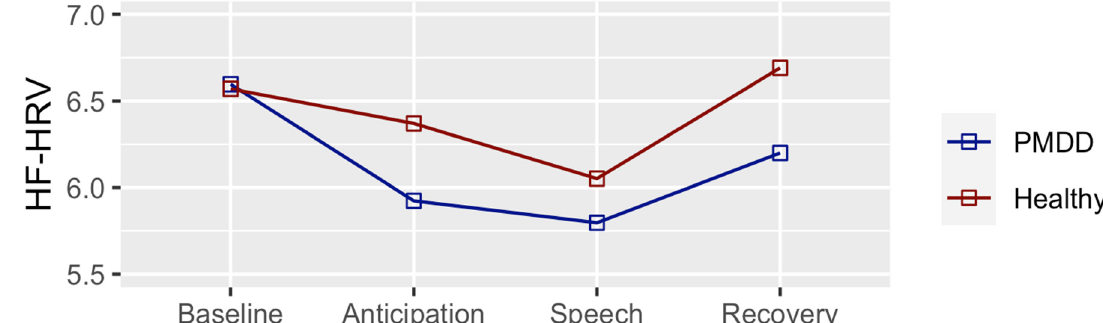
Figure 1. HF-HRV Changes Across Different Phases of the Trier Social Stress Test According to Group. Relative to baseline, HF-HRV of the PMDD group was reduced during anticipation ( p ≤ 0.05) and speech ( p ≤ 0.01). No significant changes relative to baseline were observed in the healthy participants, who displayed a significant difference in the speech vs. recovery contrast ( p ≤ 0.05). This contrast was not significant in the PMDD group. Table 2. HRV Changes Across TSST Timepoints According to Diagnosis.